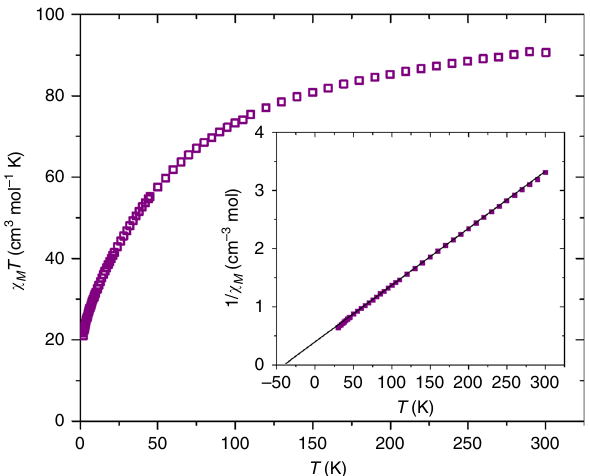
Fig. 5 Magnetic susceptibility of 1 as a function of temperature. The magnetic susceptibility data have been measured in an applied magnetic fi eld of H = 0.1 T over the temperature range T = 2-300 K. The data is plotted as χ M T vs. T and shows characteristic antiferromagnetic behavior. The inset shows the 1/ χ M vs. T data; the solid line is a fi t of the experimental data to the Curie – Weiss law.